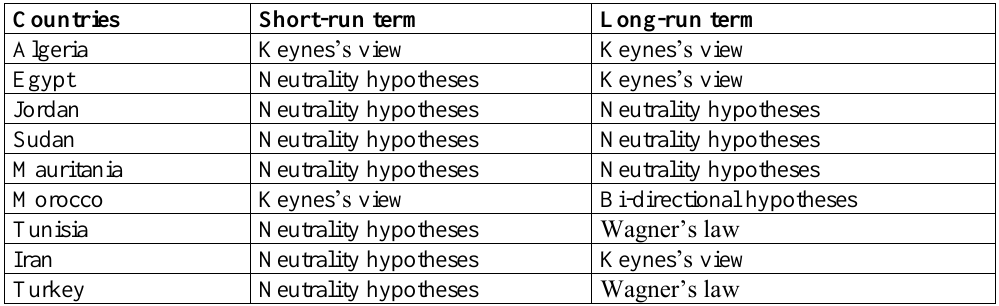
Table 8. Causality Test